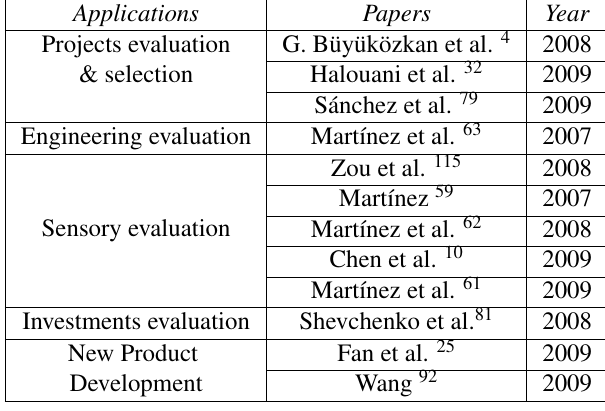
Table 4. Linguistic Evaluation